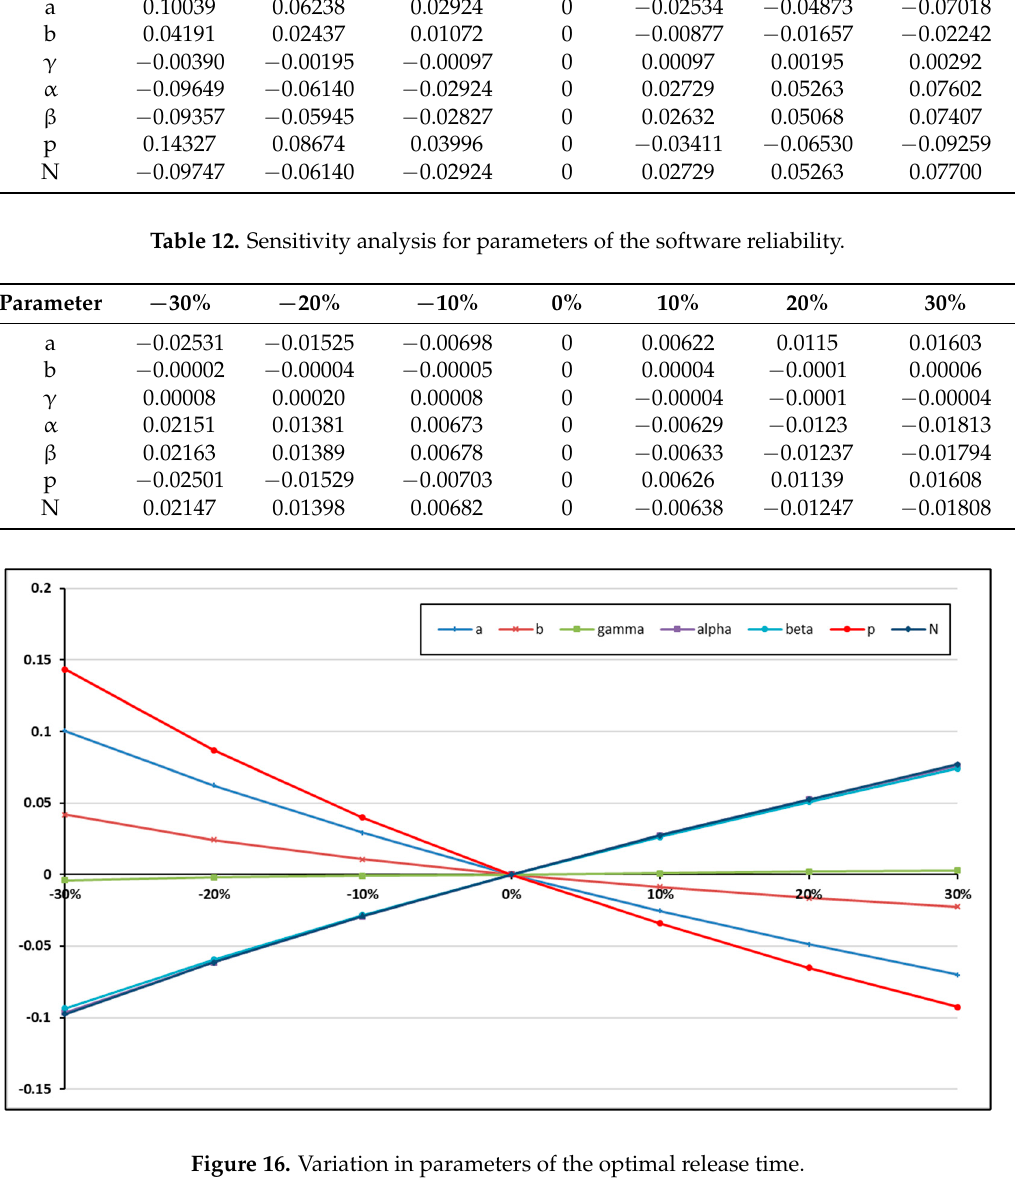
Figure 16. Variation in parameters of the optimal release time.